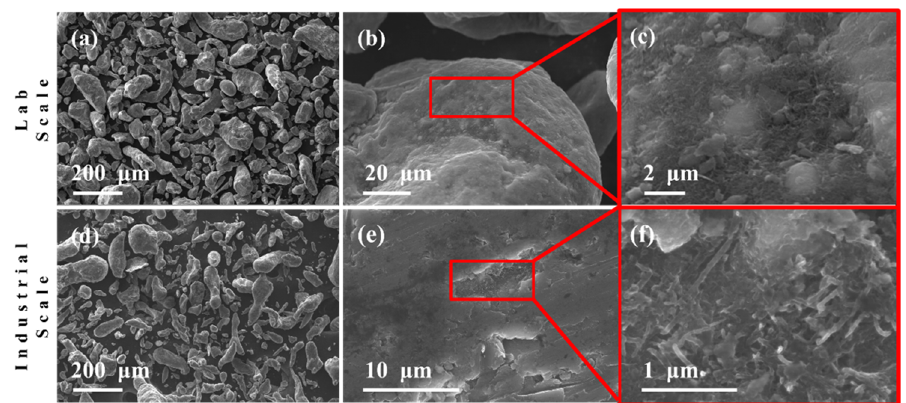
Figure 2. SE-SEM micrographs for Al-MWCNTs nanocomposite powders; ( a ) Laboratory and ( d ) Industrial scale. MWCNTs dispersion within the ball-milled Al powder surface; ( b , c ) Laboratory and ( e , f ) Industrial scale.